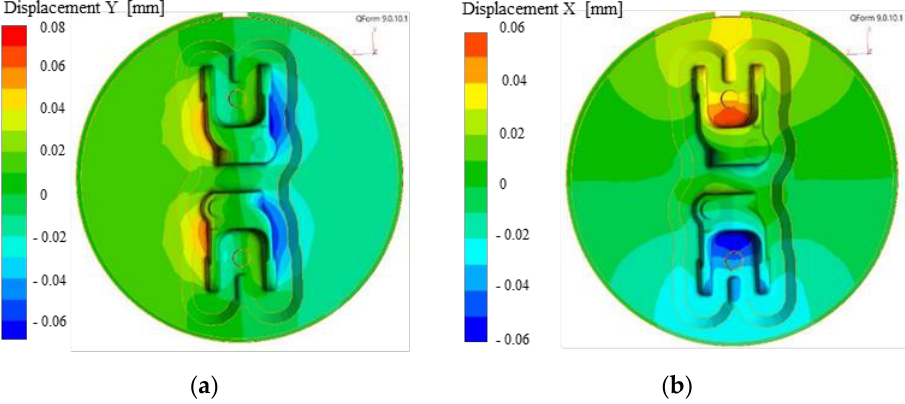
Figure 14. Results of modelling: ( a ) transverse displacement of the tool, ( b ) longitudinal displacement of the tool.